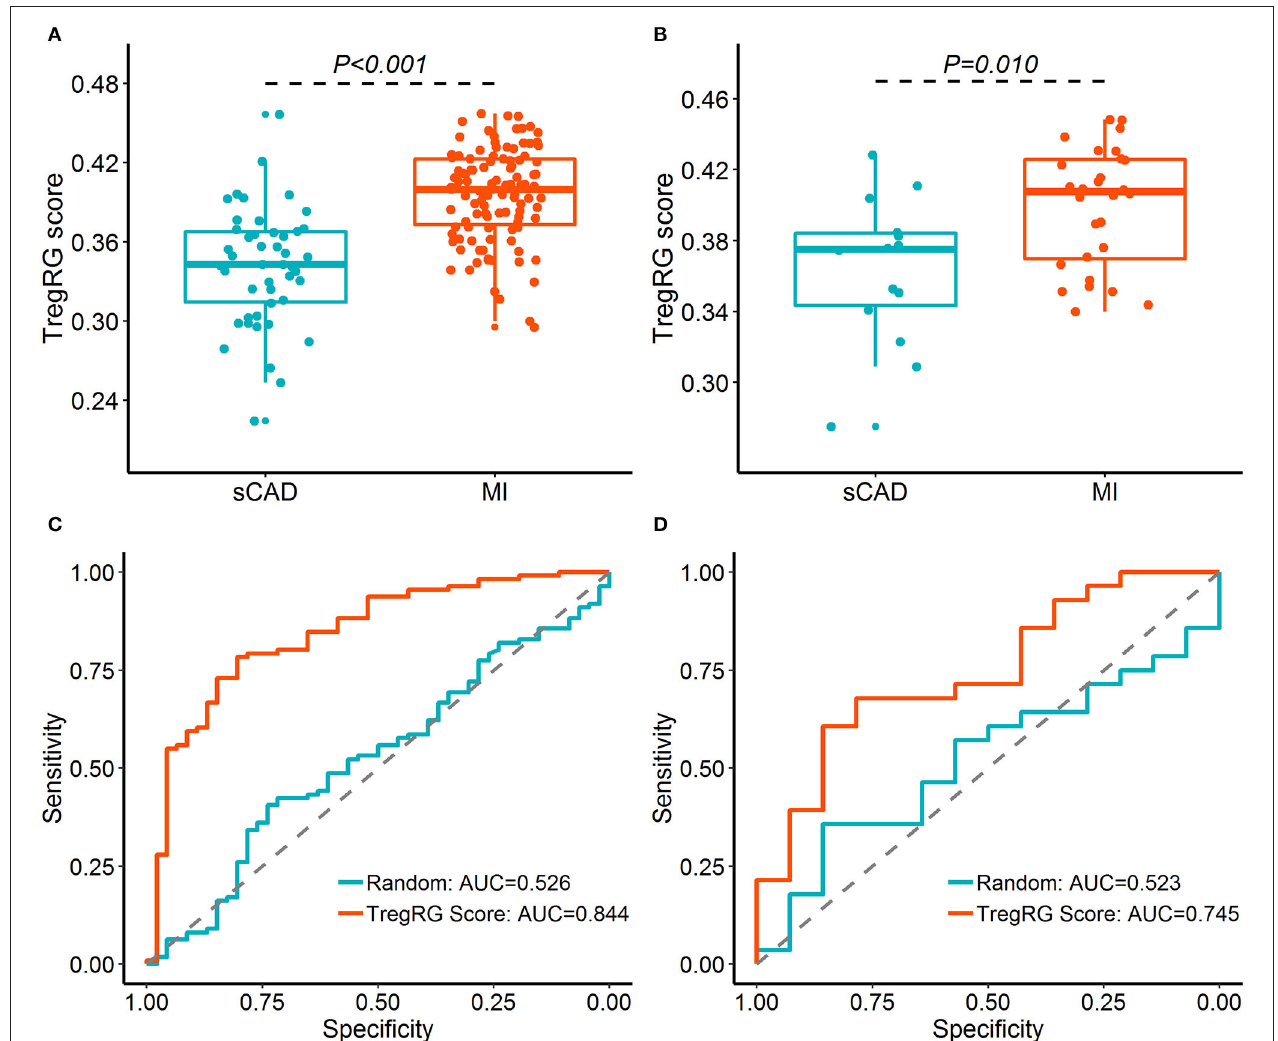
FIGURE 4 | Diagnostic performance of the TregRG score for patients with MI. (A,B) TregRG scores between patients with sCAD and MI in GSE59867 and GSE62646 datasets, respectively. (C,D) Receiver operation characteristic curves of TregRG score for diagnosis of MI in GSE59867 and GSE62646 datasets, respectively. AUC, area under the curve; MI, myocardial infarction; sCAD, stable coronary artery